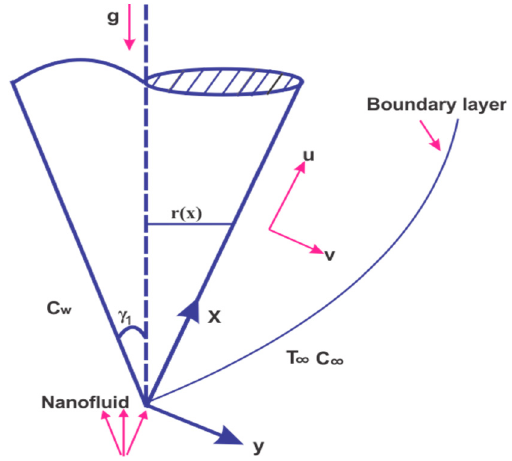
Figure 1. Schematic diagram for the flow direction.